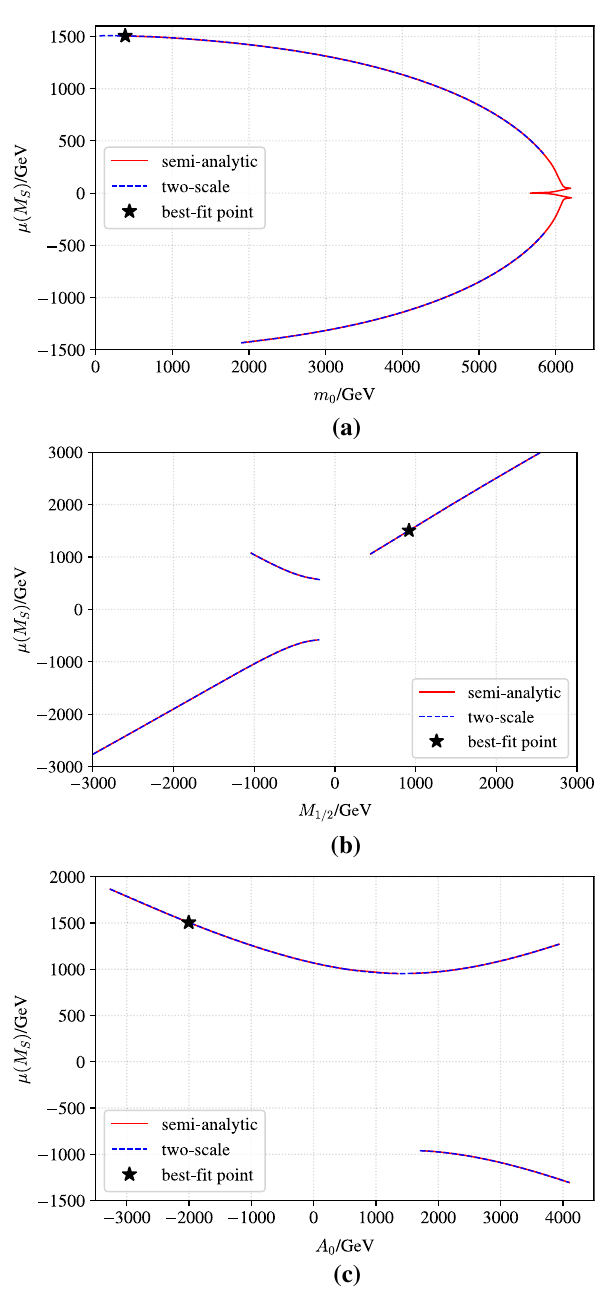
Fig. 11 The CMSSM GUT parameters and μ are varied around the best-fit point from Ref. [4] using the two-scale solver and the different semi-analytic solvers (cf. Table1). In a the best-fit point lies in a region without multiple solutions. In b , c no multiple solutions appear at all – apart from the expected ones which differ by sign